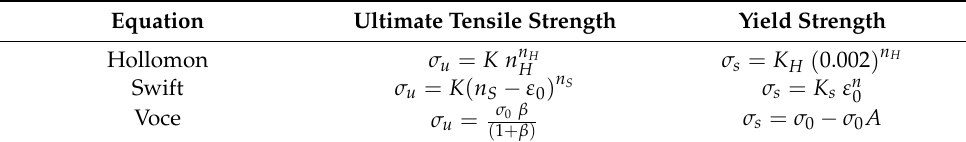
Table 1. Hollomon, Swift and Voce equations to assess the ultimate tensile strength and the yield strength